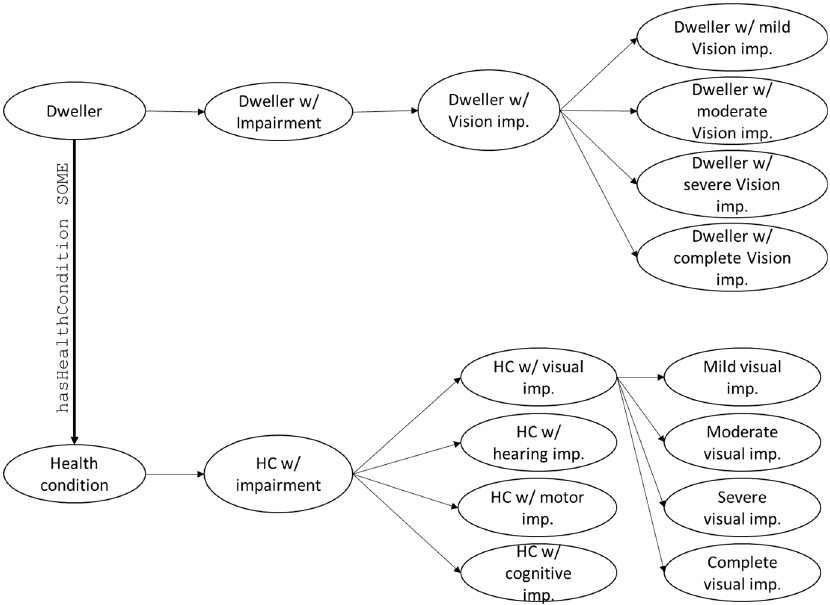
Figure 4. An excerpt of the classification of dwellers and their health conditions (concepts are represented with circles). HC, health condition; w/, with; imp., impairment.